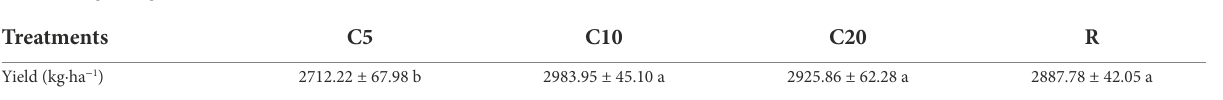
Data represent the mean ± standard deviations, Analysis of variance (Duncan’s multiple comparison test) was used to test the significance of differences. The different lowercase letters represent significant differences ( p < 0.05). C5, C10, and C20 represent soybean continuous cropping treatments for 5, 10, and 20 years, respectively, and R represents soybean-corn rotational cropping